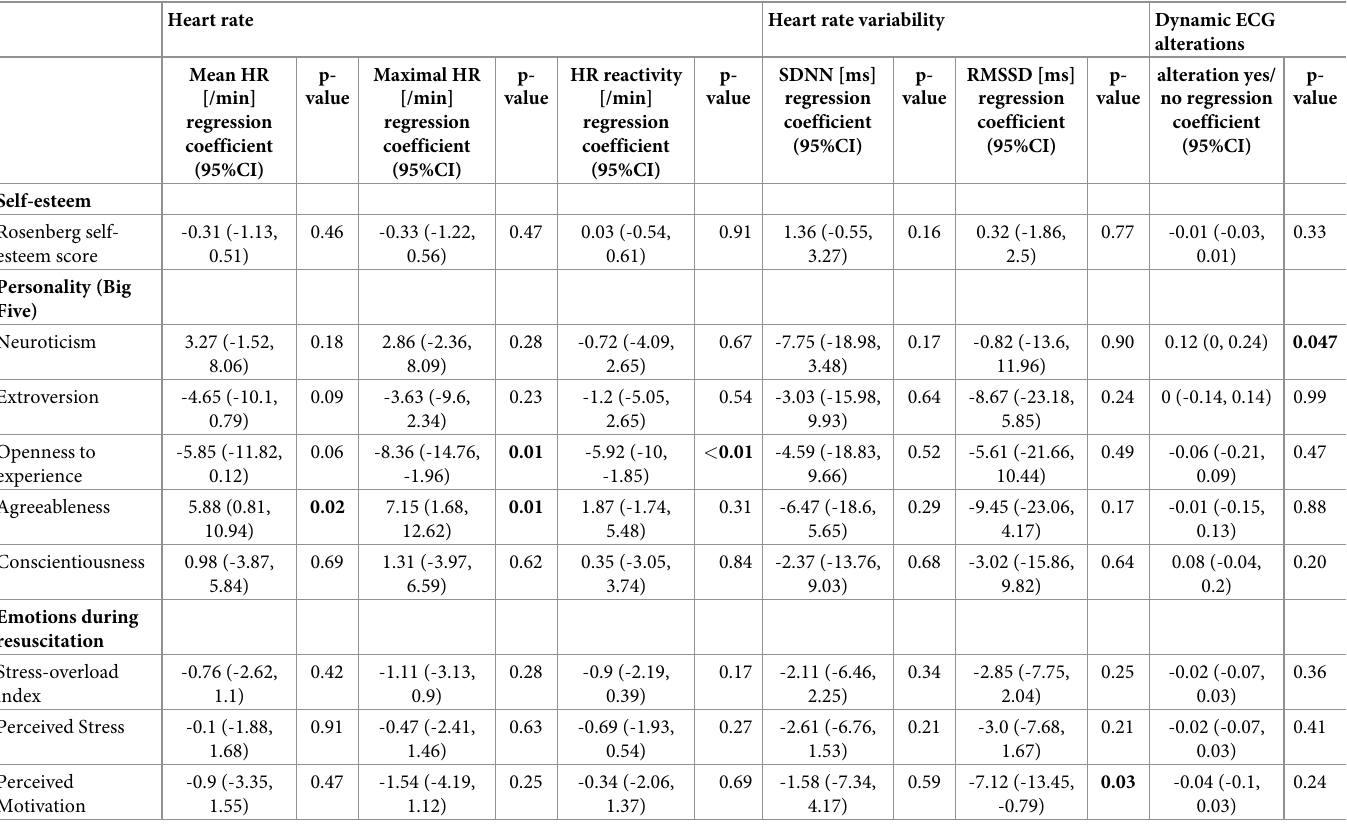
Table 3. Association of psychological variables of individuals with ECG stress parameters (univariate